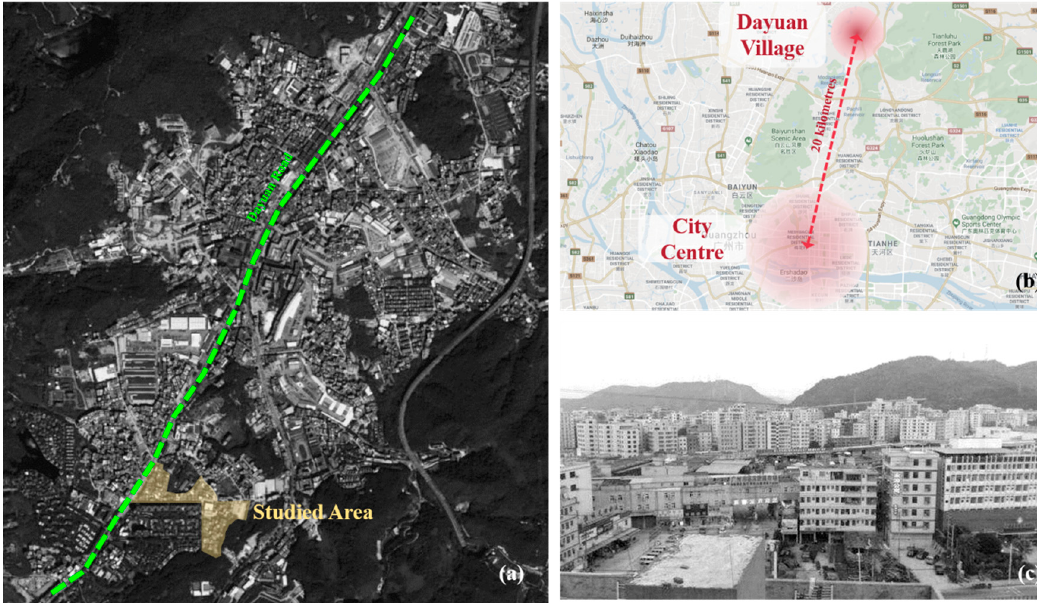
Figure 1. ( a ) the location of the study area (left); ( b ) the location of Dayuan Village with respect to the Guangzhou city centre (top right); ( c ) a photo of the study area (bottom right).